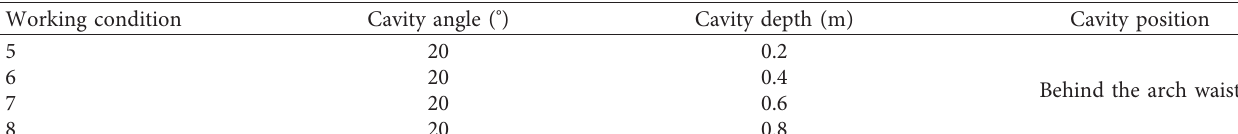
Figure 13: Safety coefficient of each section of the segment for different angle cavities behind the vault. Table 5: Numerical simulation conditions of cavities at different depths.